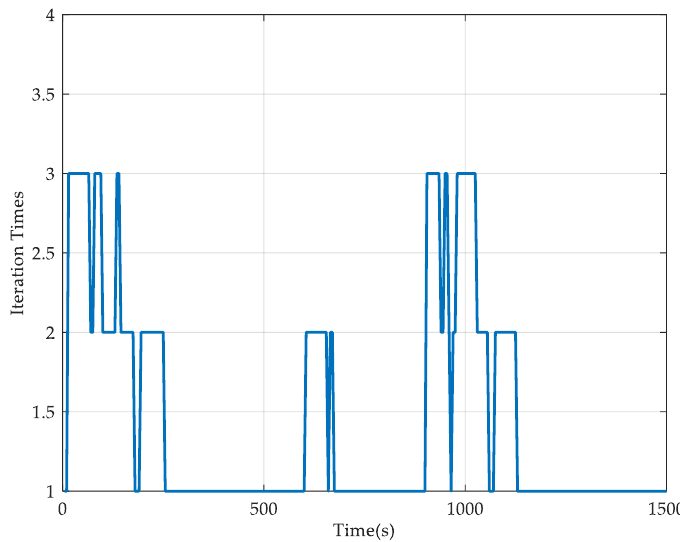
Figure 9. The iteration times when the DiMPC is applied to the steam/ water loop.